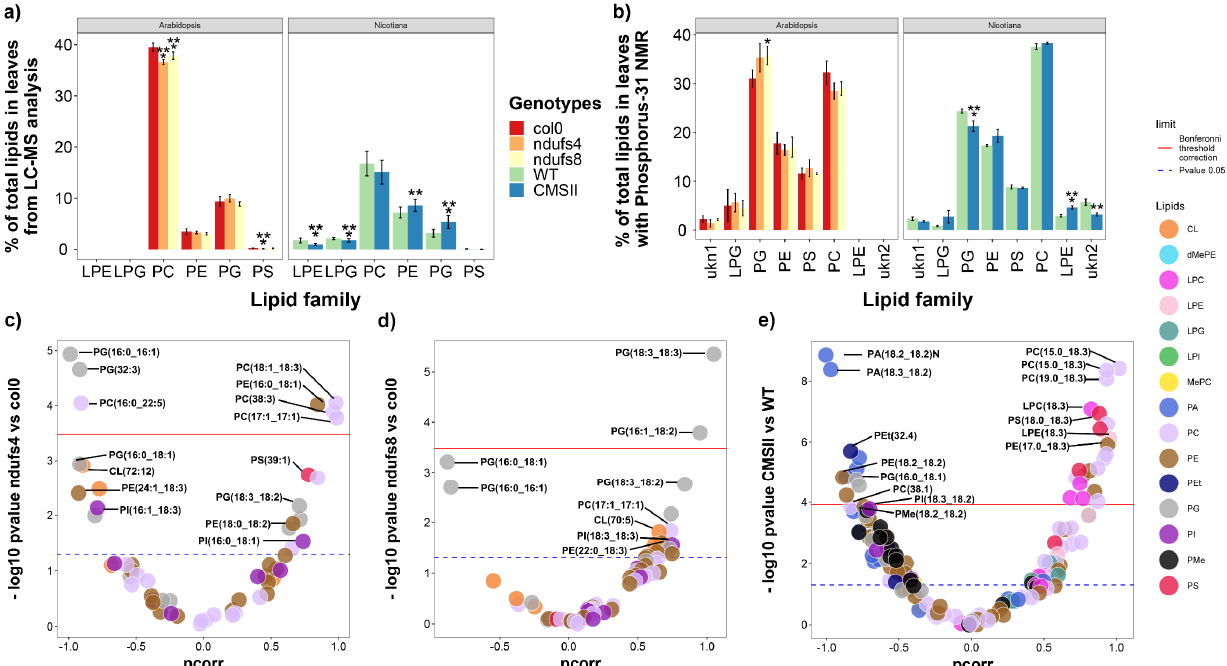
Figure 5. Leaf phospholipid pattern from both LC-MS and 31 P NMR analysis in wild-type and CI mutants: CMSII (tobacco) and ndufs4 and ndufs8 (Arabidopsis). ( a ) Phospholipid families’ contents in percentage of total LC-MS signal. ( b ) Phospholipid families in percentage of total absolute phospholipid amount determined by 31 P-NMR. ( c – e ) Volcano plots showing the weight in sample discrimination (p corr value from OPLS-DA multivariate analysis) against the p -value (Welch t-test, univariate analysis) to show best lipid biomarkers between mutants (on the left) and wild-type (on the right). The colour legend on right indicates phospholipid subfamilies in ( c – e ). A magnified version of this figure is provided in Supplementary Materials. Asterisks refer to statistical significance (*, p < 0.05; **, p < 0.01; ***, p < 0.001).